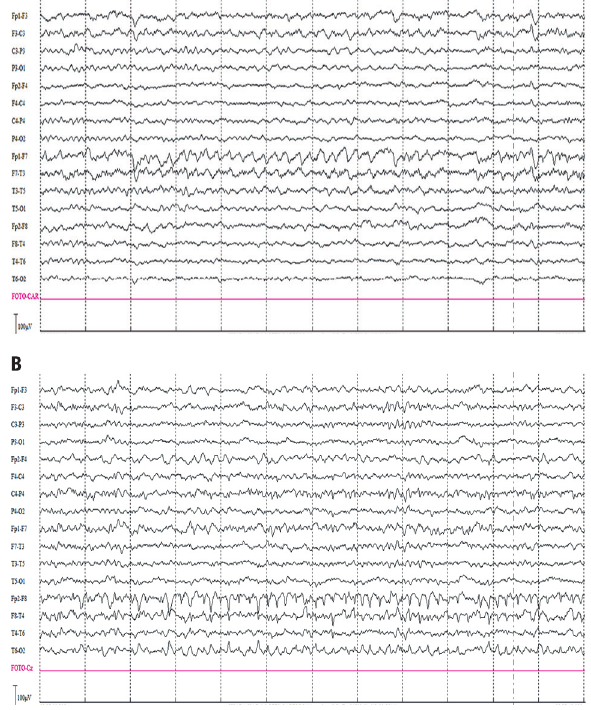
Figure 2. [A] EEG at clinical onset of symptoms has a TIRDA pattern at left temporal. [B] Through the same EEG, a seizure at right temporal is also register. In the follow up, it became normal without epileptic activity (not